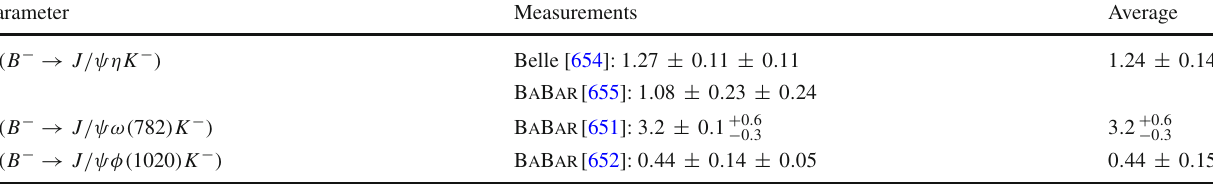
Table 160 Decays to J /ψ and one kaon II [ 10 − 4 ] Parameter